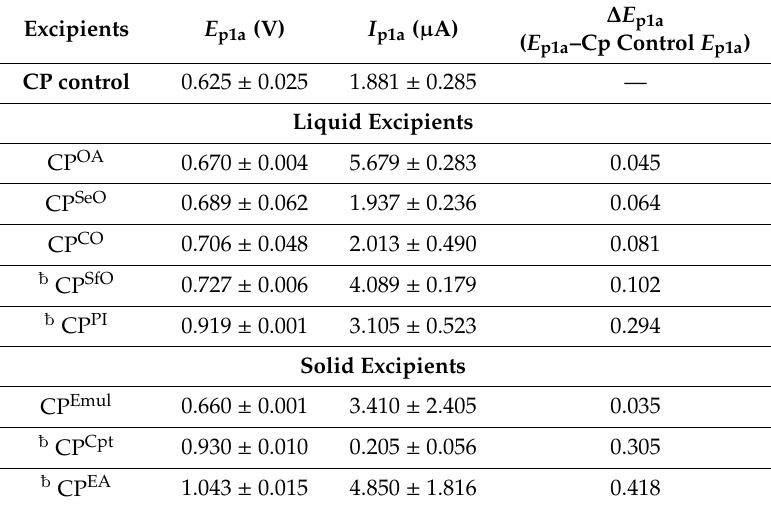
Table 2. E p1a and I p1a values obtained for 1% (m/m) CRV in the carbon paste electrode (CPE) control and different modified CPEs.